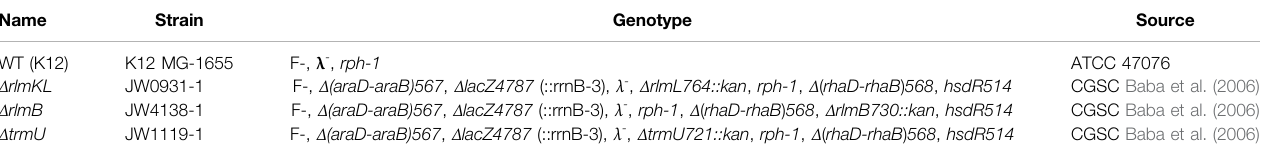
TABLE 1 | E. coli strains used for oxidative exposure studies of ribosomes and rRNA.